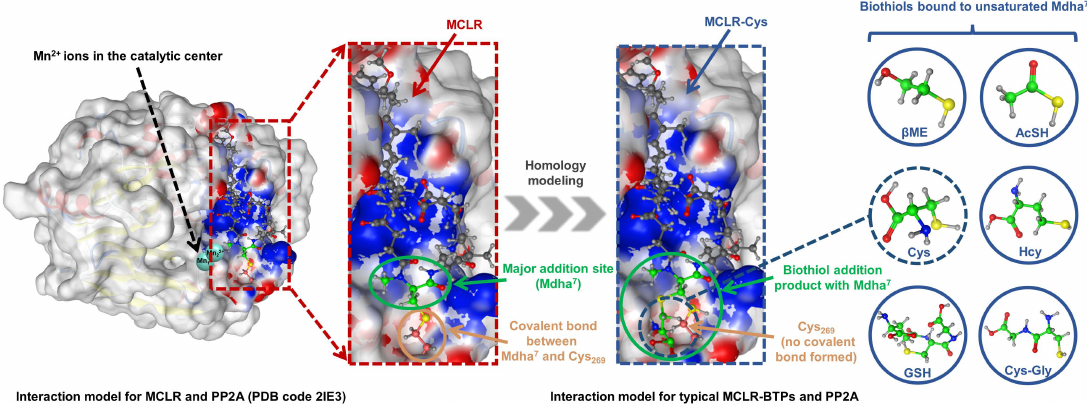
Figure 4. Illustration of interaction-model construction for MCLR-BTP-PP2A complexes (with no PDB models) based on homology modeling